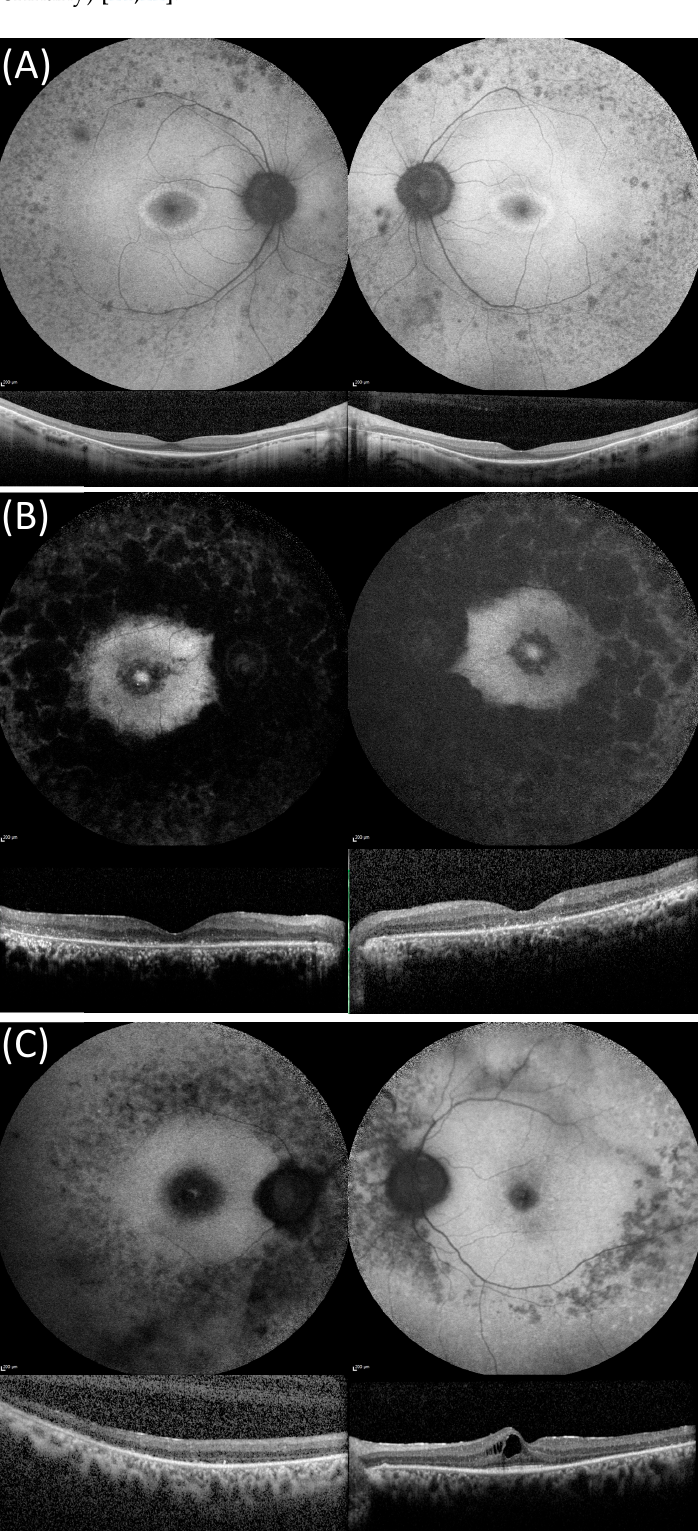
Figure 1. Fundus autofluorescence (FAF) and optical coherence tomography (OCT) images in three compound heterozygous patients from our cohort showing the disease stages described by Fakin et al. [19] for USH2A variants. ( A ) FAF and OCT imaging of patient 50 with non-syndromic autosomal